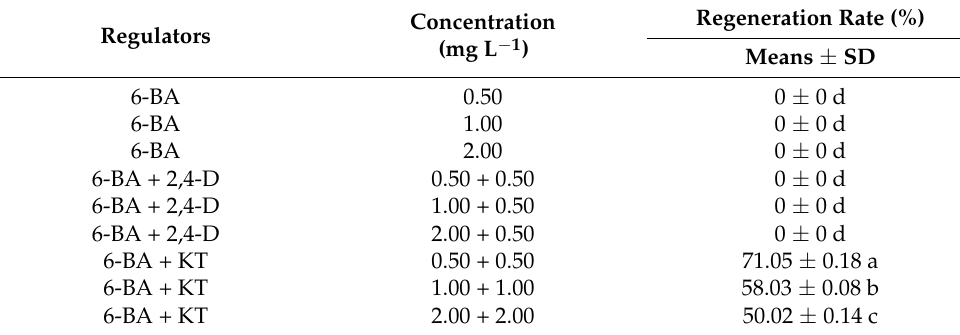
Table 1. The optimal determination of regulators on regeneration of goosegrass calli.